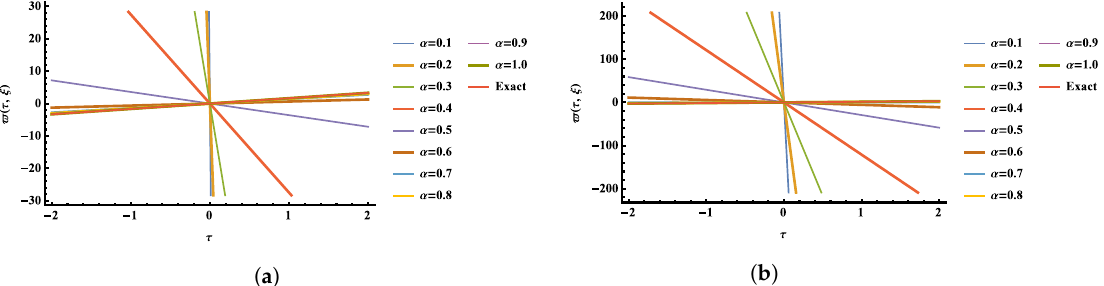
Figure 13. Three-dimensional plots of ( a ) the exact and ( b ) FNAM solutions at τ ∈ [ − 10,10 ] , ξ ∈ [ 0,0.1 ] and a = c = 1 for Example